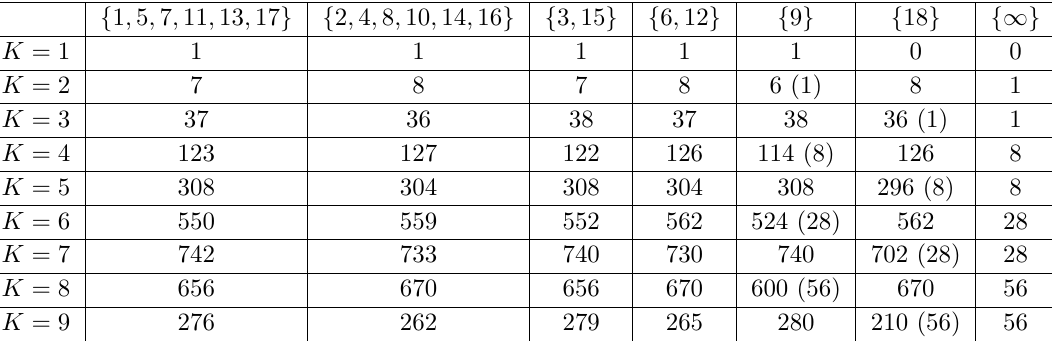
Table 15 . Number of Bethe roots for decomposed BAE with M = 18. Open